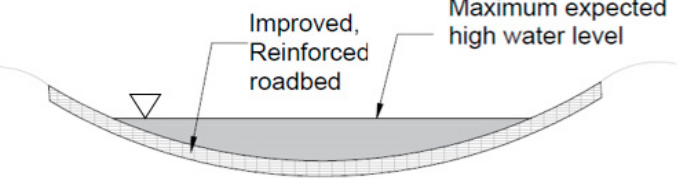
Figure 1. Schematic of an unvented ford.